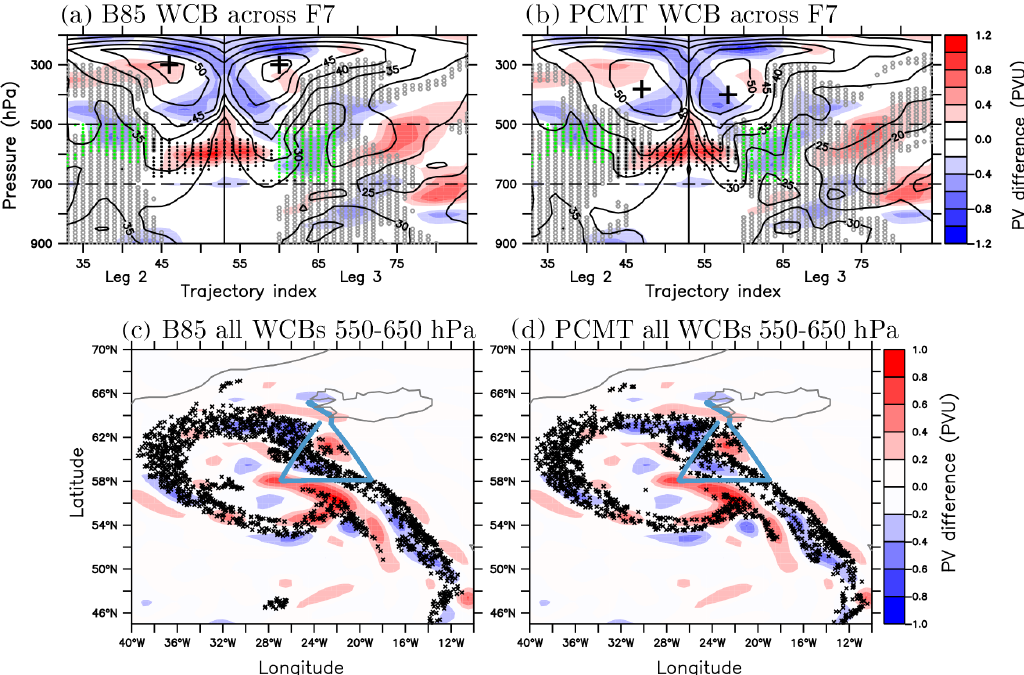
Figure 5. (a, b) Vertical cross-section of the difference (PCMT − B85) in PV (shading) along the second and third leg of Flight F7 at 15:00UTC, 2 October 2016. The wind speed (black contours) and intersection of WCB trajectories with an ascent of 300hPa in 24h with F7 (grey circles) are shown for (a) B85 and (b) PCMT. In panels (a) and (b) , the thick crosses represent the wind speed maxima in legs 2 and 3 for B85 and PCMT, respectively. Trajectories where PV differences are positive and negative between 500 and 700hPa are in black and green dots, respectively. (c, d) PV difference at 600hPa (shading) and WCB trajectories, initialised in the warm sector, positions between 550–650hPa (crosses) at 15:00UTC 2 October 2016 for (c) B85 and (d) PCMT. The flight is shown by the blue